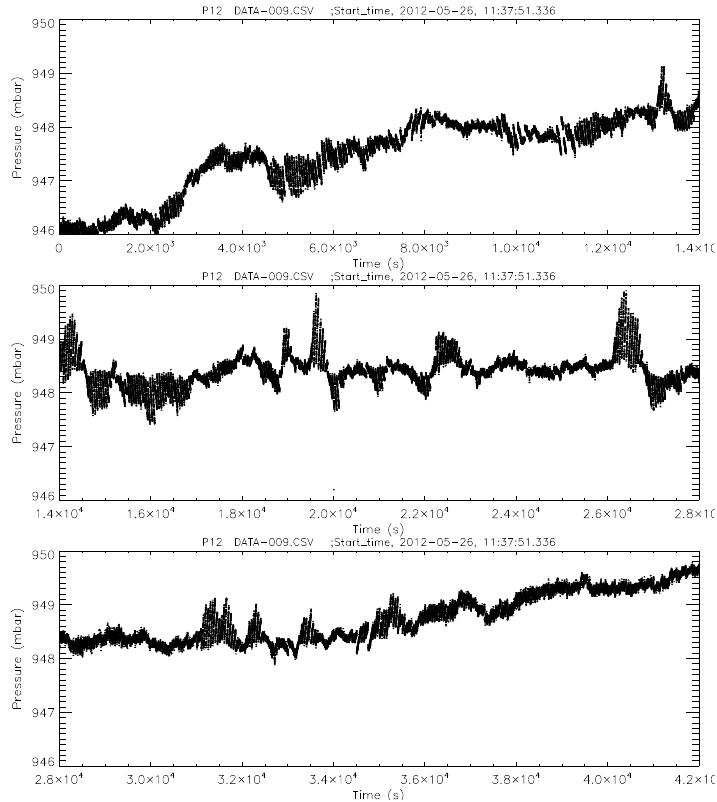
Fig. 12. Uncorrected pressure record over daylight hours. Beginning around 13000s (i.e., around local noon), an oscillation in pressure develops with a period of about 1000s, and is seen most prominently at the middle of the center panel at around 14:00LT when dust devil activity is near its peak. In this uncorrected data, the periodic pressure cycle is somewhat highlighted by the sawtooth due to correlated temperature